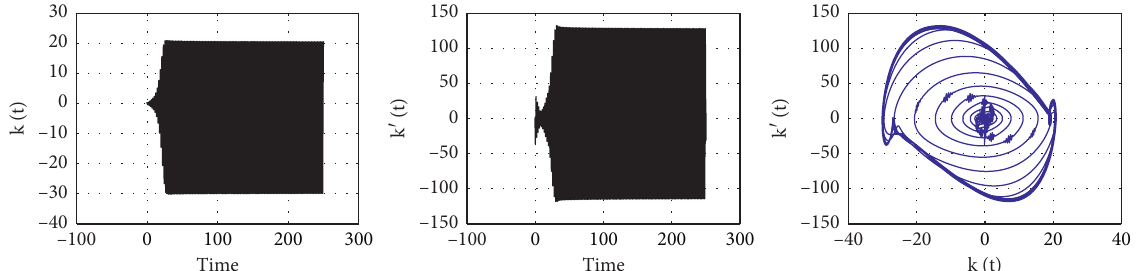
Figure 8: Solutions and phase trajectories at a � 0.125, q � 0.25, and τ � 1.